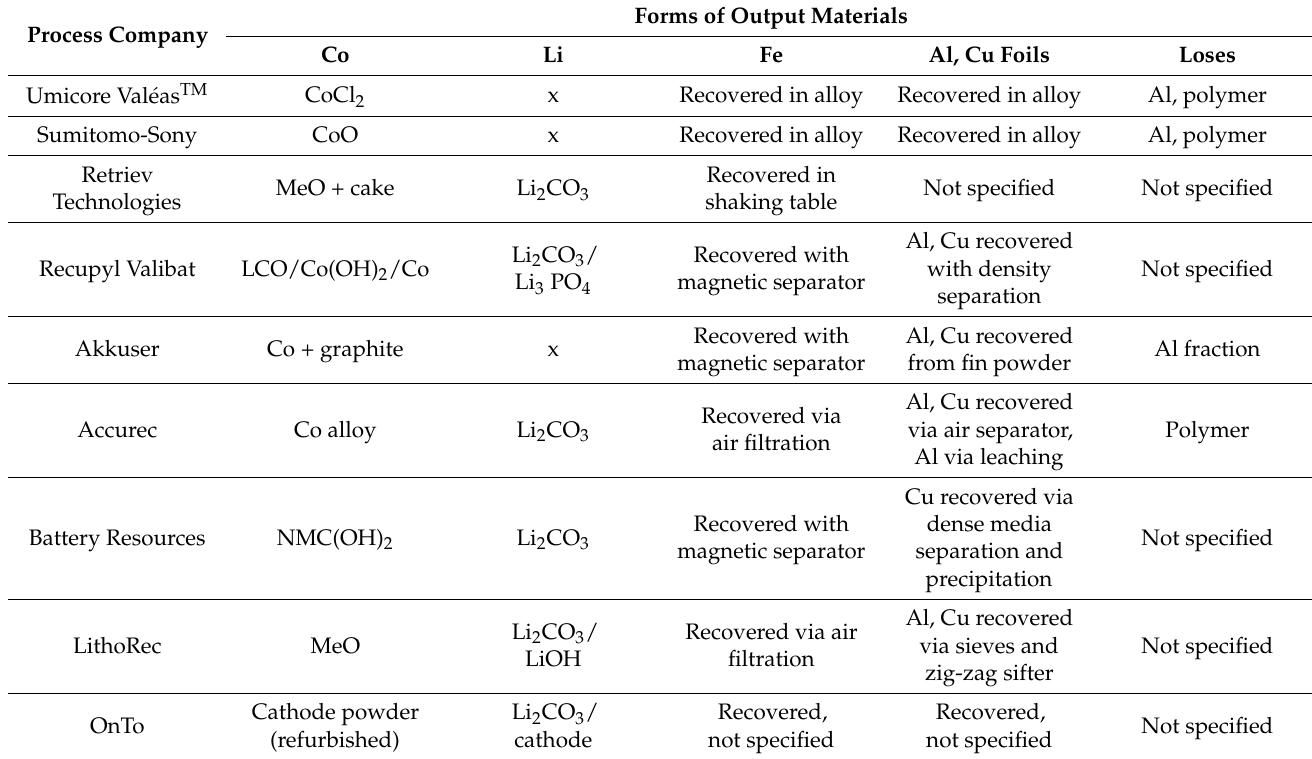
Table 6. Recovery materials of nine recycling companies with their specified form of output. Reprinted and edited from Batteries, Vol. 5, Vel á zquez-Mart í nez et al. [10], A critical review of lithium-ion battery recycling processes from a circular economy perspective, no 4., Copyright